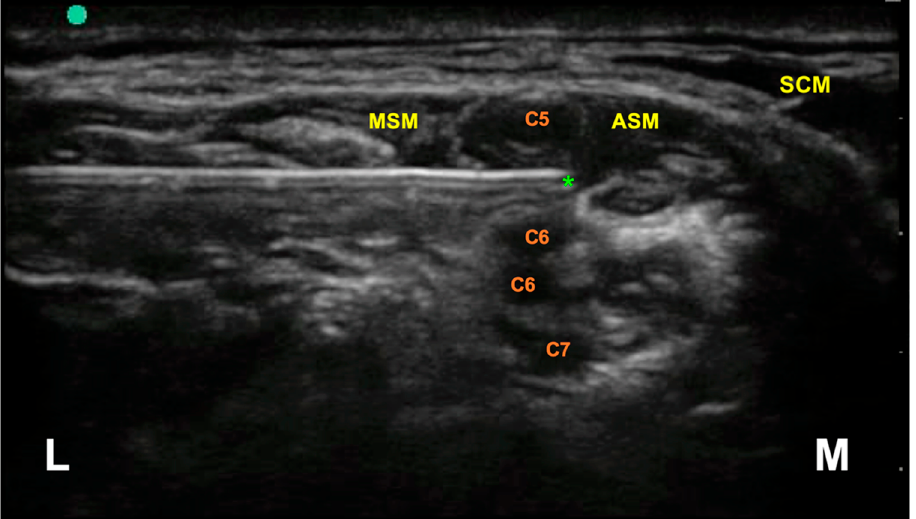
Figure 3. Interscalene brachial plexus, ultrasound anatomy. The asterisk indicates the target of the needle tip during the block, located between the C5 and C6 nerve roots. MSM = medial scalene muscle; ASM = anterior scalene muscle; SCM = sternocleidomastoid muscle; L = Lateral; M = Me-